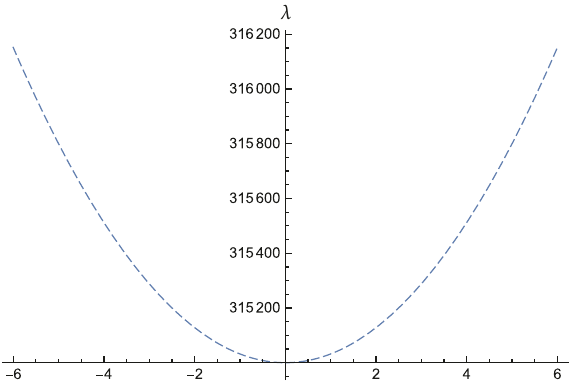
Figure 10: Diagram of dispersion relation among frequency ( 𝜆 ) and wave number ( ℎ 1